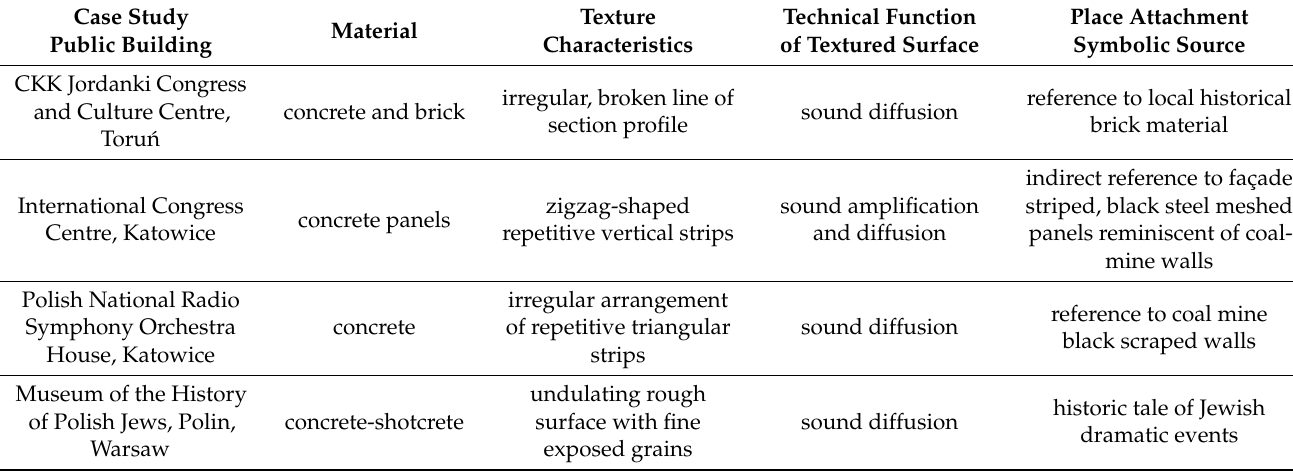
Table 2. Comparison of the influence of building techniques on the environmetal performance of public building interiors in terms of their technical, aesthetic, and symbolic features.